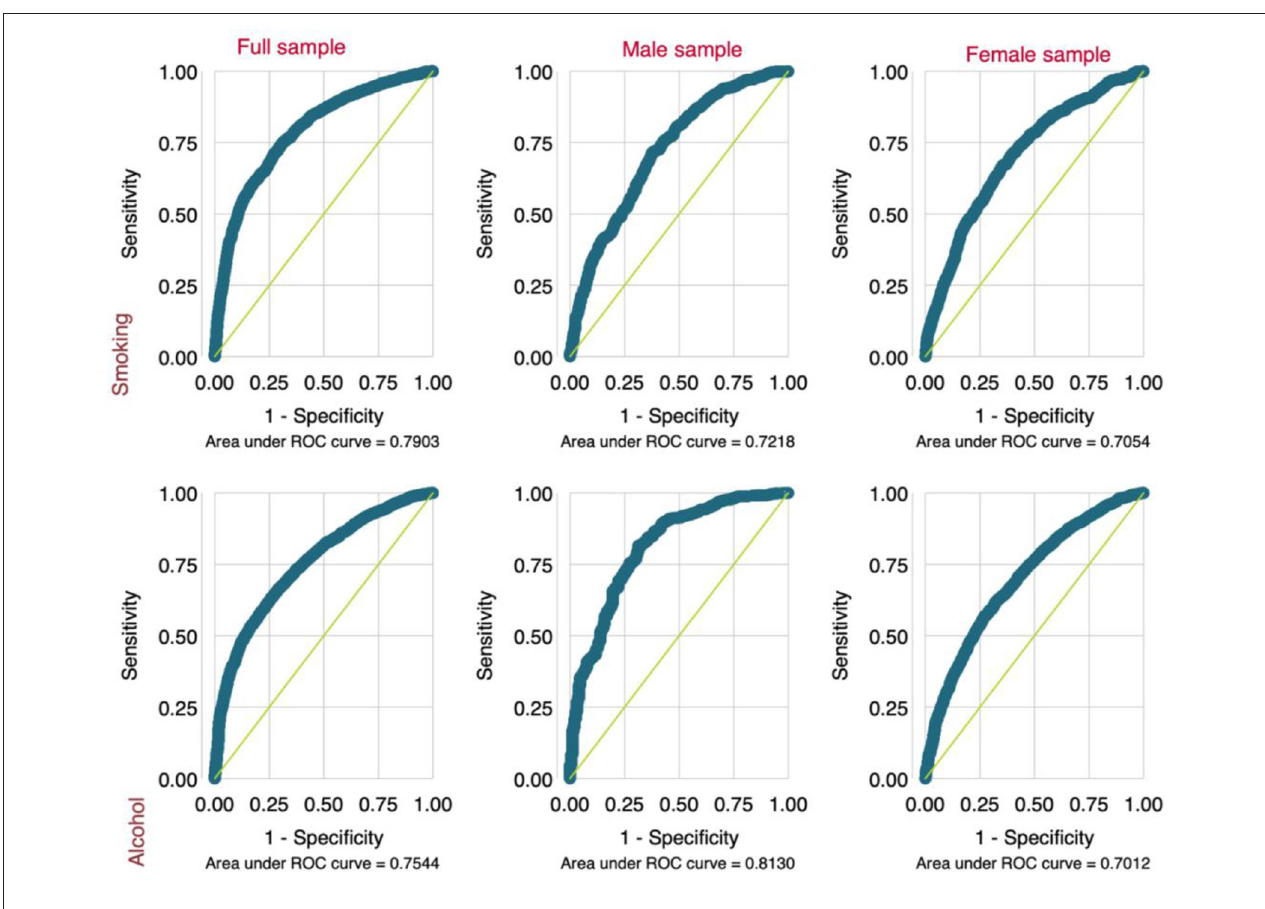
FIGURE 4 | ROC curve values of the regression models.